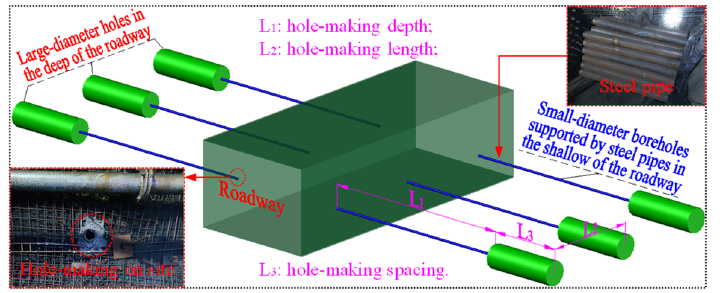
Figure 7. Schematic for the layout of hole-making in the two ribs of the roadway.